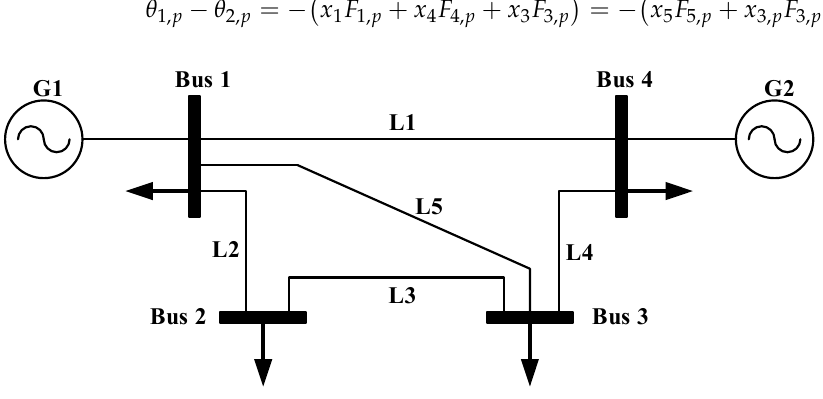
Figure 1. An example of a four-bus power system.